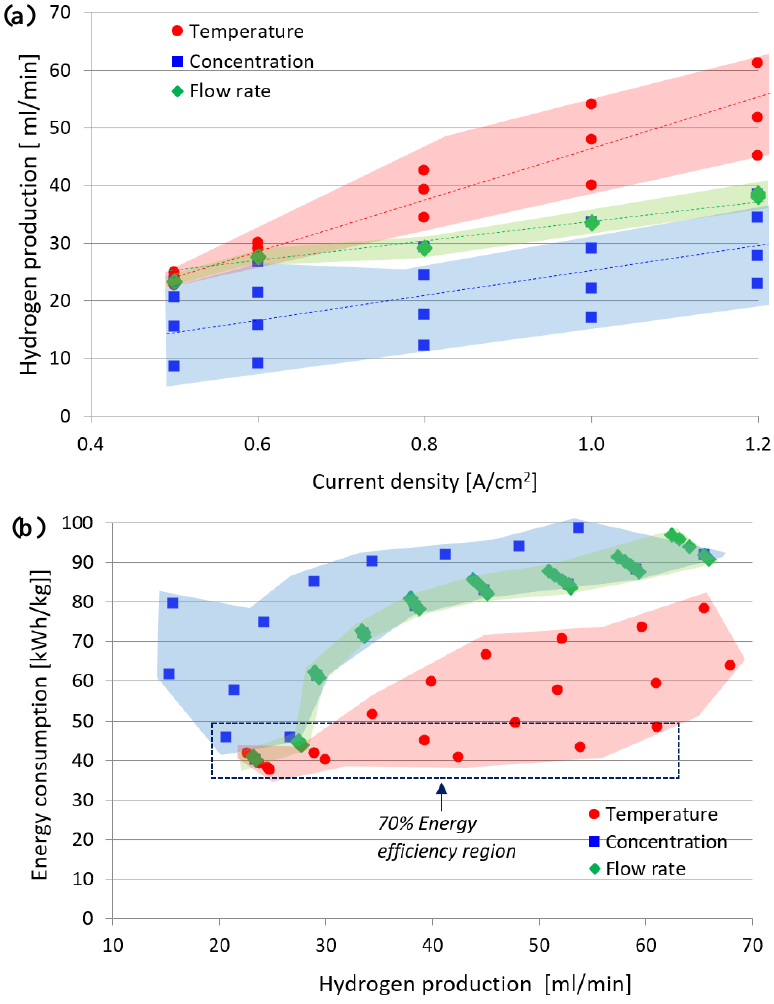
Figure 11. Summarized data for each operating condition: ( a ) Hydrogen flow rate, ( b ) Energy con- sumption for AEM electrolysis unit.